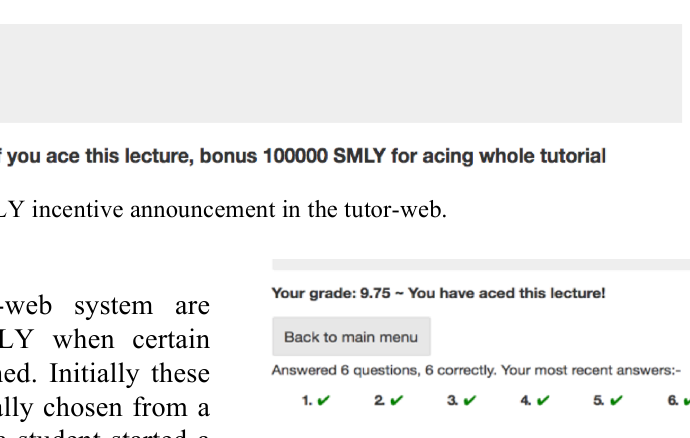
Fig. 3. Announcement of acing a lecture.